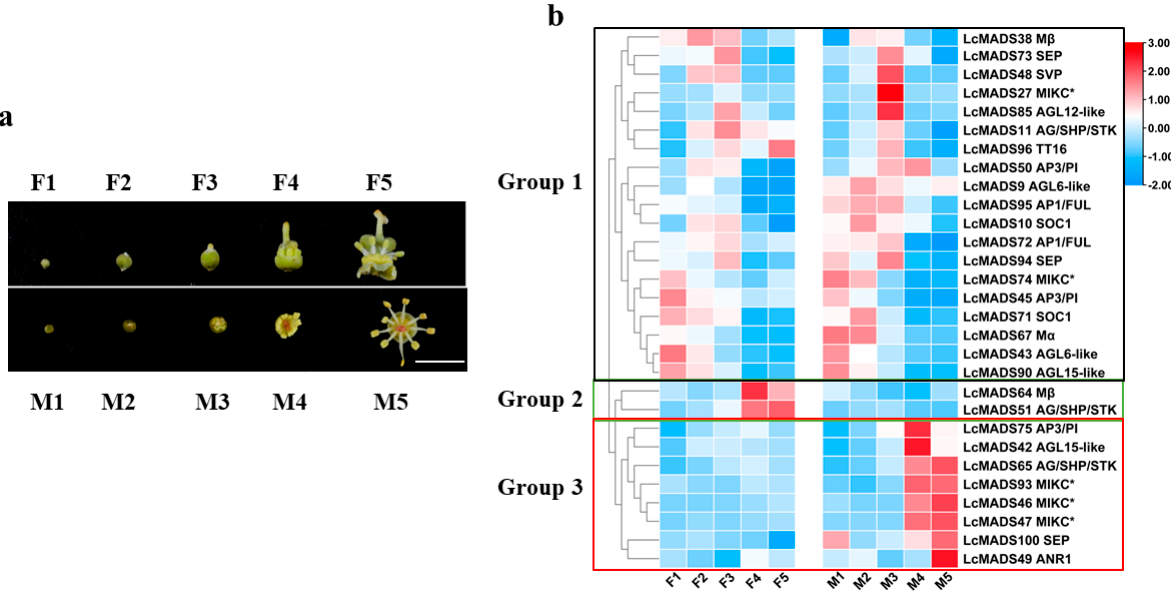
Figure 7. Expression profiles of litchi MADS-box genes at different stages of flower development. Fl, 0.5–1 mm female flower buds; F2, 1–1.5 mm female flower buds; F3, 1.5–2 mm female flower buds; F4, half-bloom female flowers; F5, full-bloom female flowers; M1, 0.5–1 mm male flower buds; M2, 1–1.5 mm male flower buds; M3, 1.5–2 mm male flower buds; M4, half-bloom male flowers; M5, full-bloom male flowers ( a ). FPKM values of litchi MADS-box genes from the transcriptome data were normalized to z-scores for each row to construct the heat map ( b ).